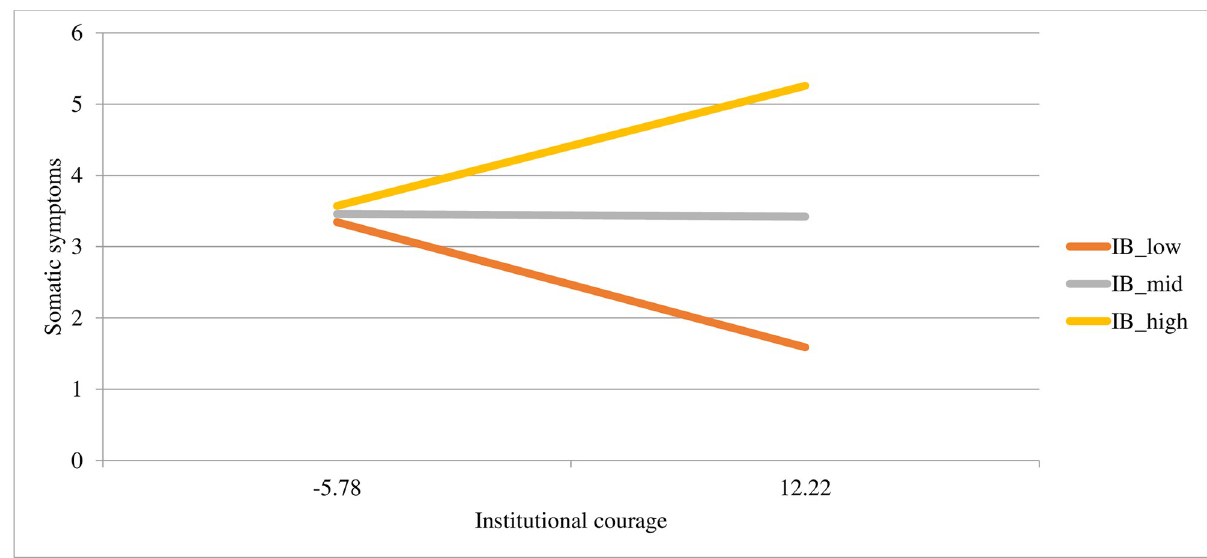
Fig 5. Associations between different levels of institutional courage (at -1SD, the mean, and +1SD) with somatic symptoms at different levels of institutional betrayal (at -1SD and +1SD).